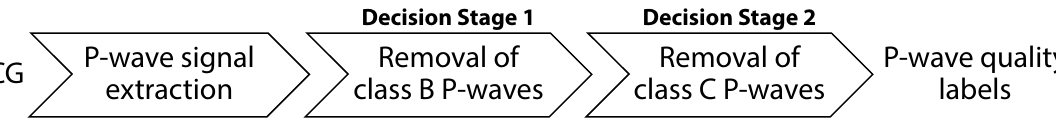
Figure 2. The P-wave quality index (PQI) tool consisted of three steps. In the first, the P-waves were identified in the electrocardiogram (ECG) and extracted. P-wave template morphologies and P-wave features were extracted from these P-waves and were used in two different decision-making stages. This resulted in each P-wave being labelled as either high (class A) or low quality (classes B and C), allowing artefact-corrupted and unreliable P-waves to be excluded from the